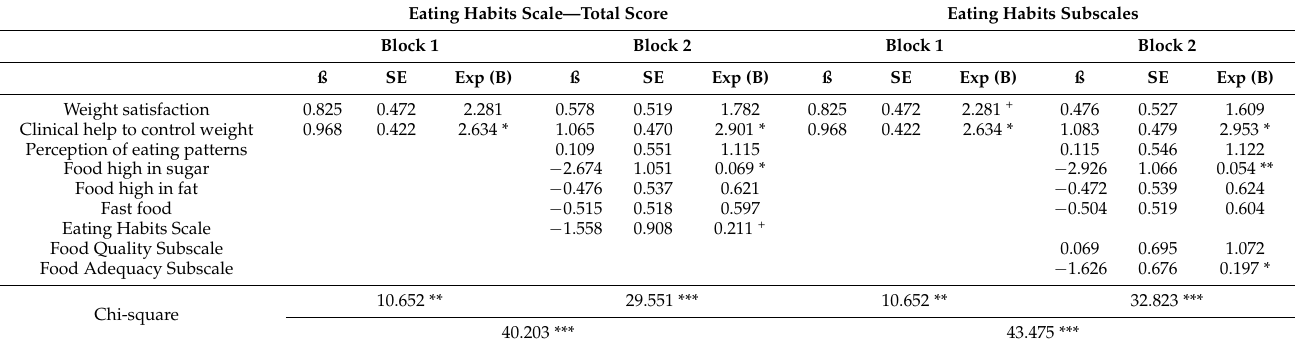
Table 3. Binary logistic regression to ascertain the likelihood that participants belong to the group with food addiction problems attending to weight satisfaction, previous clinical help to control weight, eating habits, eating pattern, and food choices (ideal consumption) of food high in sugar, high in fat, and